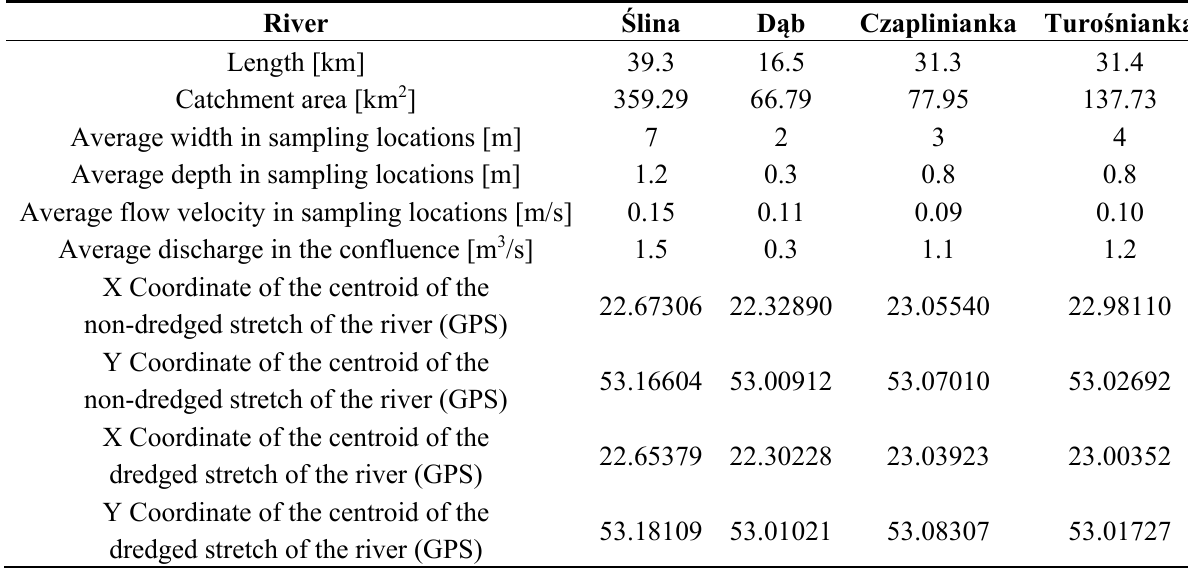
Figure 1. Study area—catchments of tributaries of the middle Narew river: D ą b, Czaplinianka, Ś lina, and Turo ś nianka. Location of selected sampling stretches, land use, hydrography, and boundaries of protected areas (Natura 2000 and Narew National Park). Table 1. Hydrological features of sampled